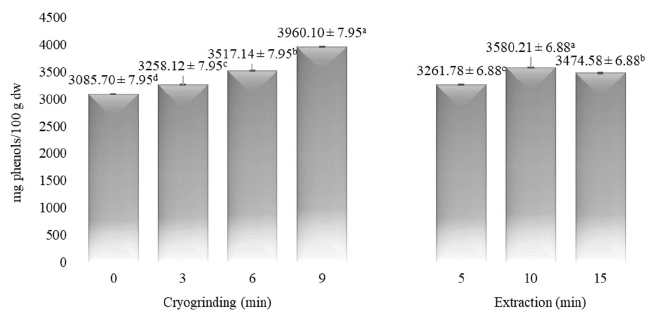
Figure 2. Influence of cryogrinding and extraction time on total phenols. Results are expressed as mean (n = 8 for cryogrinding time and n = 6 for extraction time) ± SE. Different letters indicate significant differences between the means ( p ≤ 0.05).